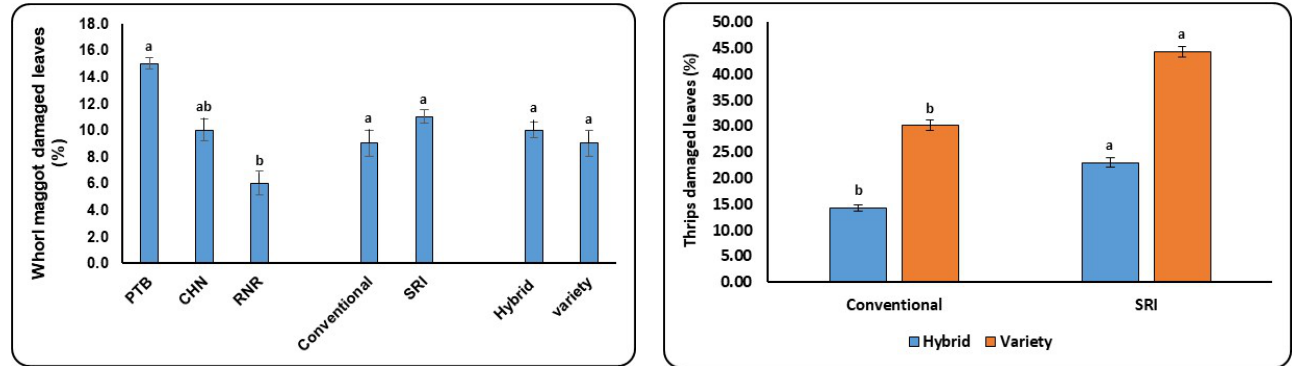
Figure 7. Incidence of whorl maggot and thrips in cultivation methods and cultivars. PTB = Pattambi, CHN = Chinsurah, RNR = Rajendranagar. Means with the same letter are not significantly different by Tukey’s HSD ( p = 0.05) across locations, methods and cultivars